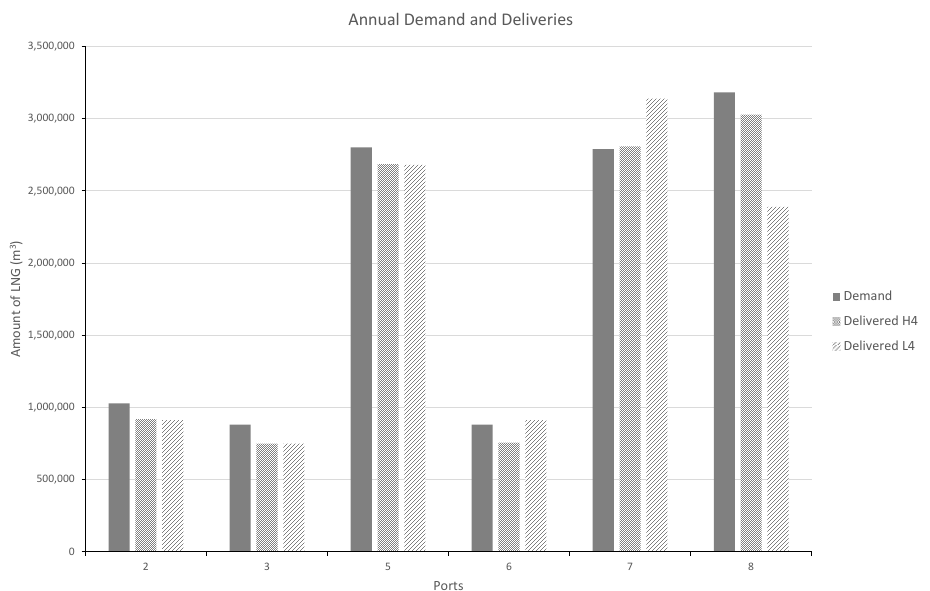
Figure 8. Annual demand and deliveries for the long-term